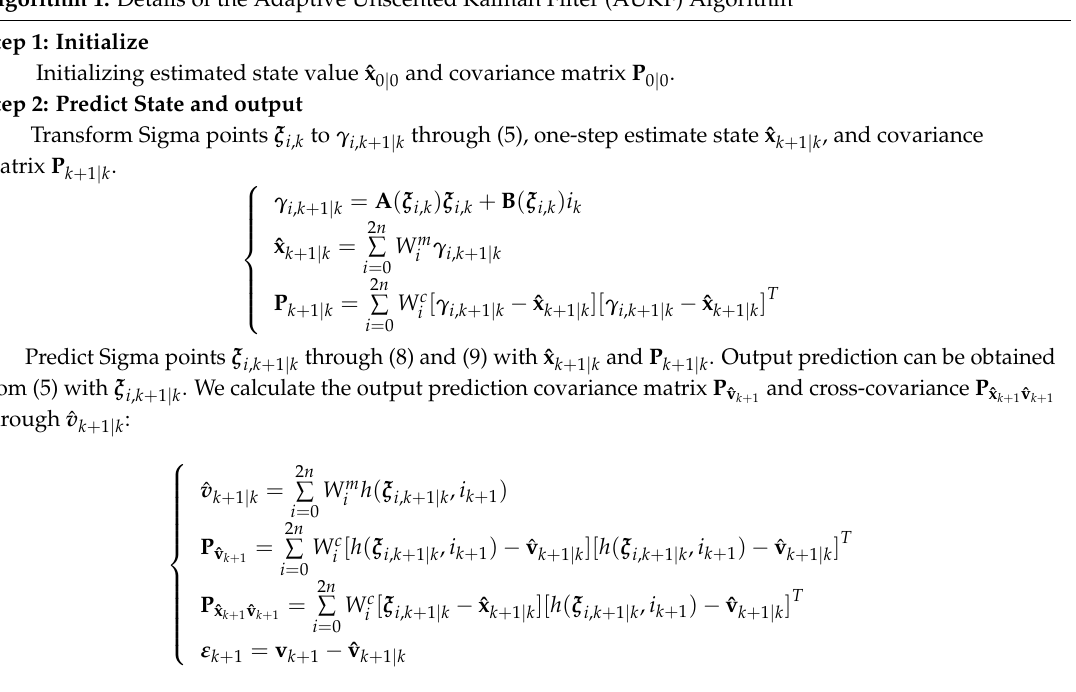
Algorithm 1. Details of the Adaptive Unscented Kalman Filter (AUKF)